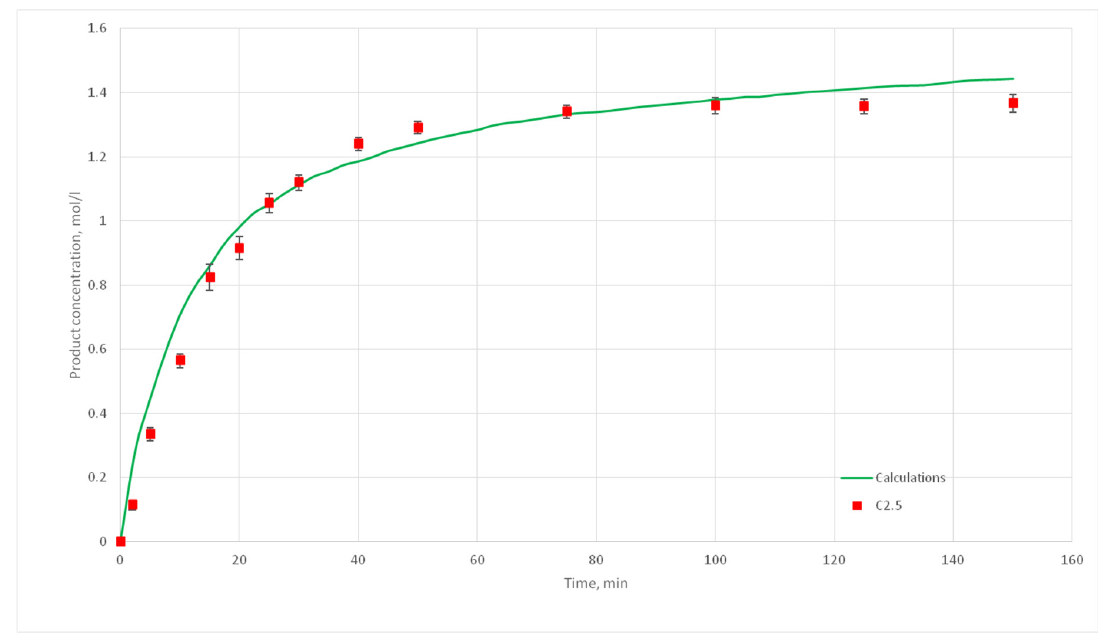
Figure 19. Calculation and experimental reaction kinetic curves for С 2.5 experiment.